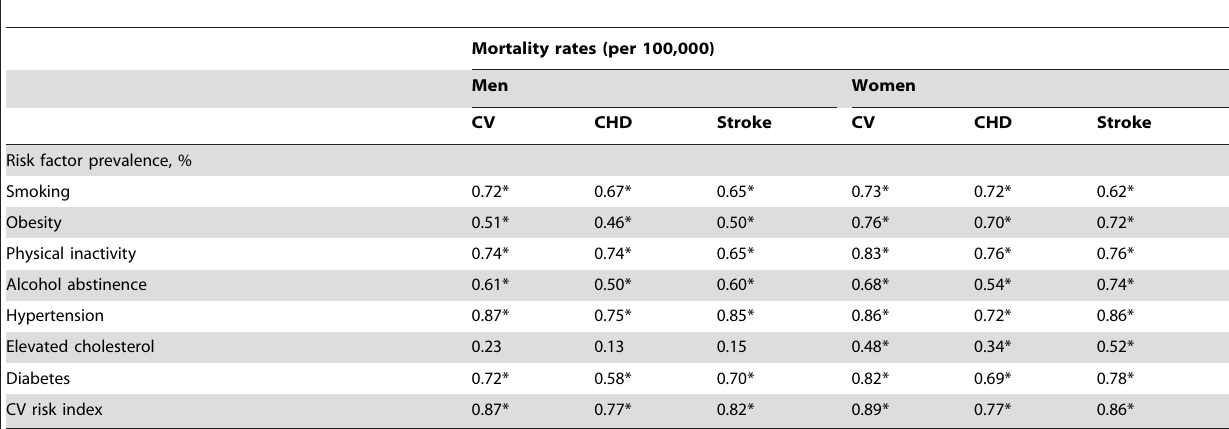
Table 2. Bivariate Pearson correlations of 2005 state-level CV risk index and risk factor prevalence for adults aged 40–69 y with 2010 cause-specific mortality rates for adults aged 45–74 y.